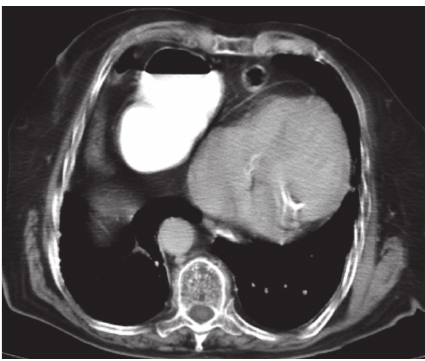
Figure 3: Intraperitoneal cavity. Pulling out hernia sac content back into abdomen by noncrashing grasper.